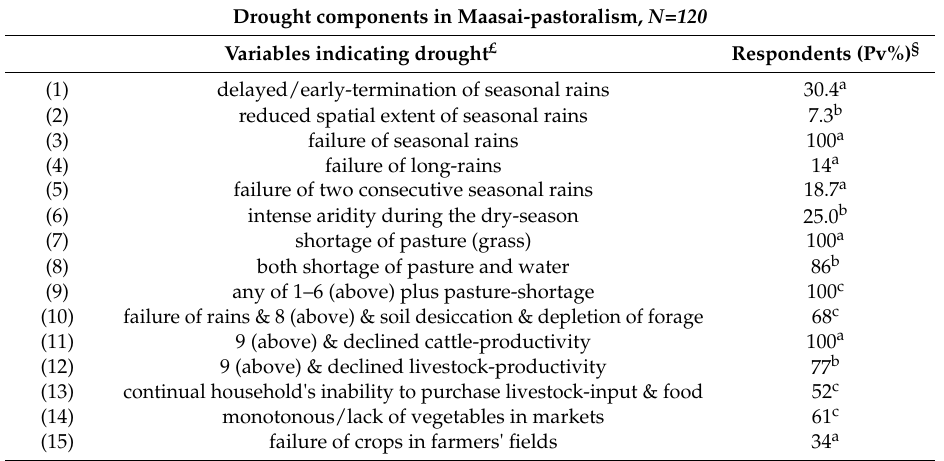
Table 1. Emic accounts on factors indicating occurrence of drought based on the Maasai’s